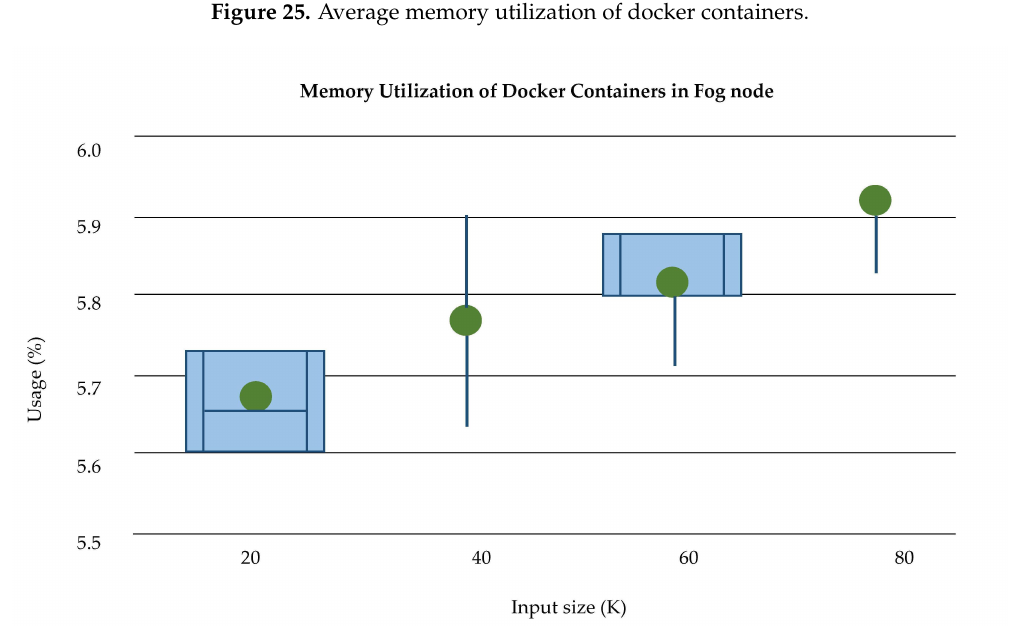
Figure 25. Average memory utilization of docker containers.